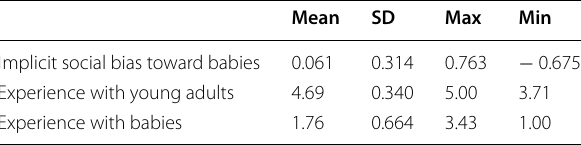
Table 6 Descriptive statistics on implicit social bias and experiences for Experiment 2